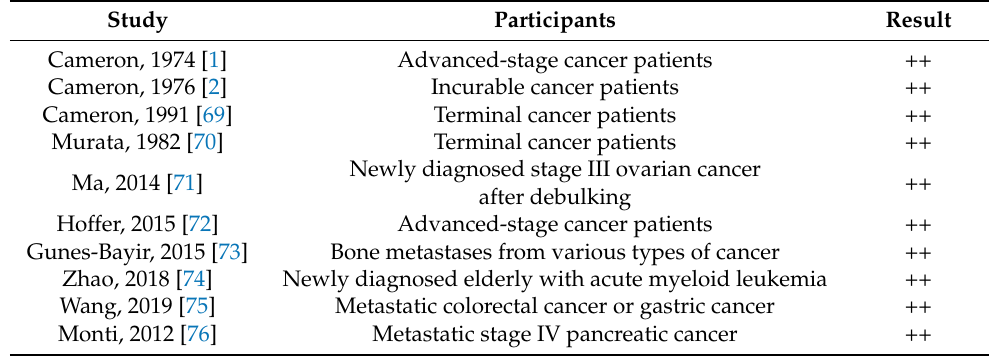
Table 1. Results of pharmacologic vitamin C